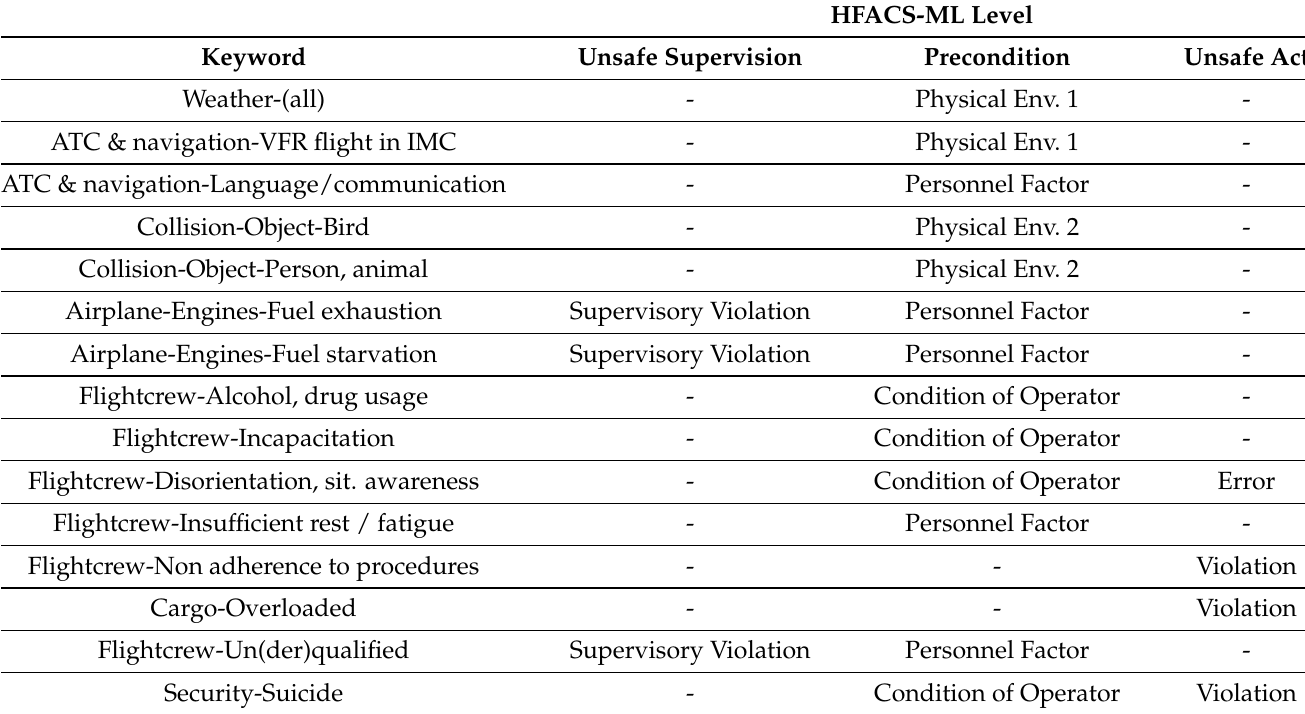
Table 1. Automated labelling